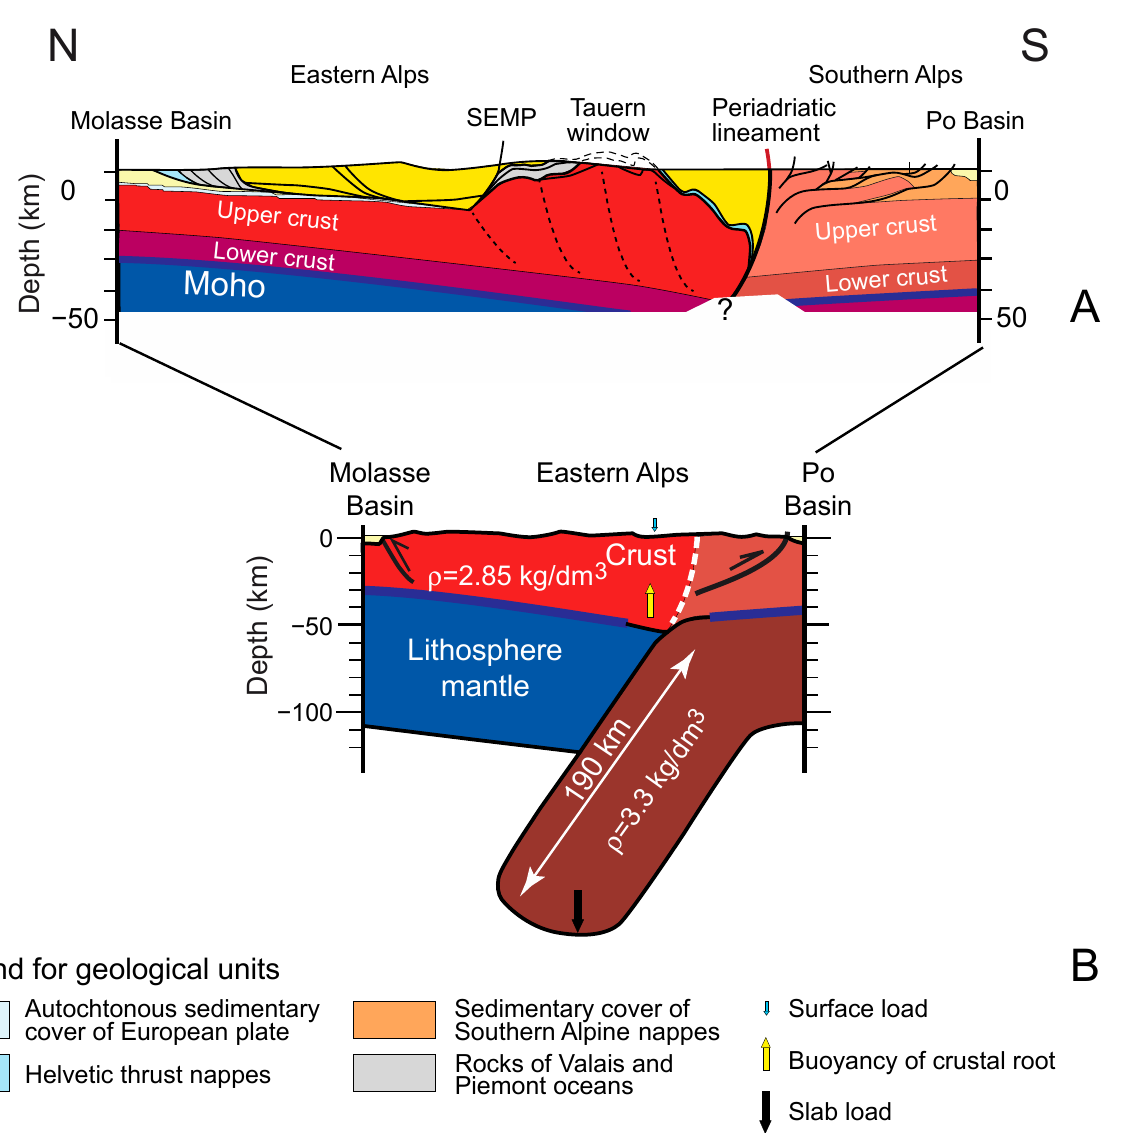
Figure 4. ( A ) Tectonic section across the Eastern Alps, modified from Rosenberg et al. [35,36] (for location see Figure 2). The cross-section shows that the orogen comprises rocks derived from the European and Adriatic continental plates, yet lithologies of Iberian origin are absent. The rocks in the Tauern Window correspond to the stretched margin of the European plate during the Mesozoic phase of spreading [31,32,35]. ( B ) Simplified geological-geophysical model of the Eastern Alps, which is derived from seismo-tomographic images [44] (along same transect as Figure 4A). Beneath the Eastern Alps, the buoyant crustal root is thinner than beneath the Central Alps, which explains the lower elevation of the surface topography in the East. This figure implies that the NNE dipping slab is of Adriatic origin [29], which has been contested [28,52]. Please refer to the text for a discussion of why we prefer the Lippitsch et al. [29] interpretation of the seismo-tomography data.